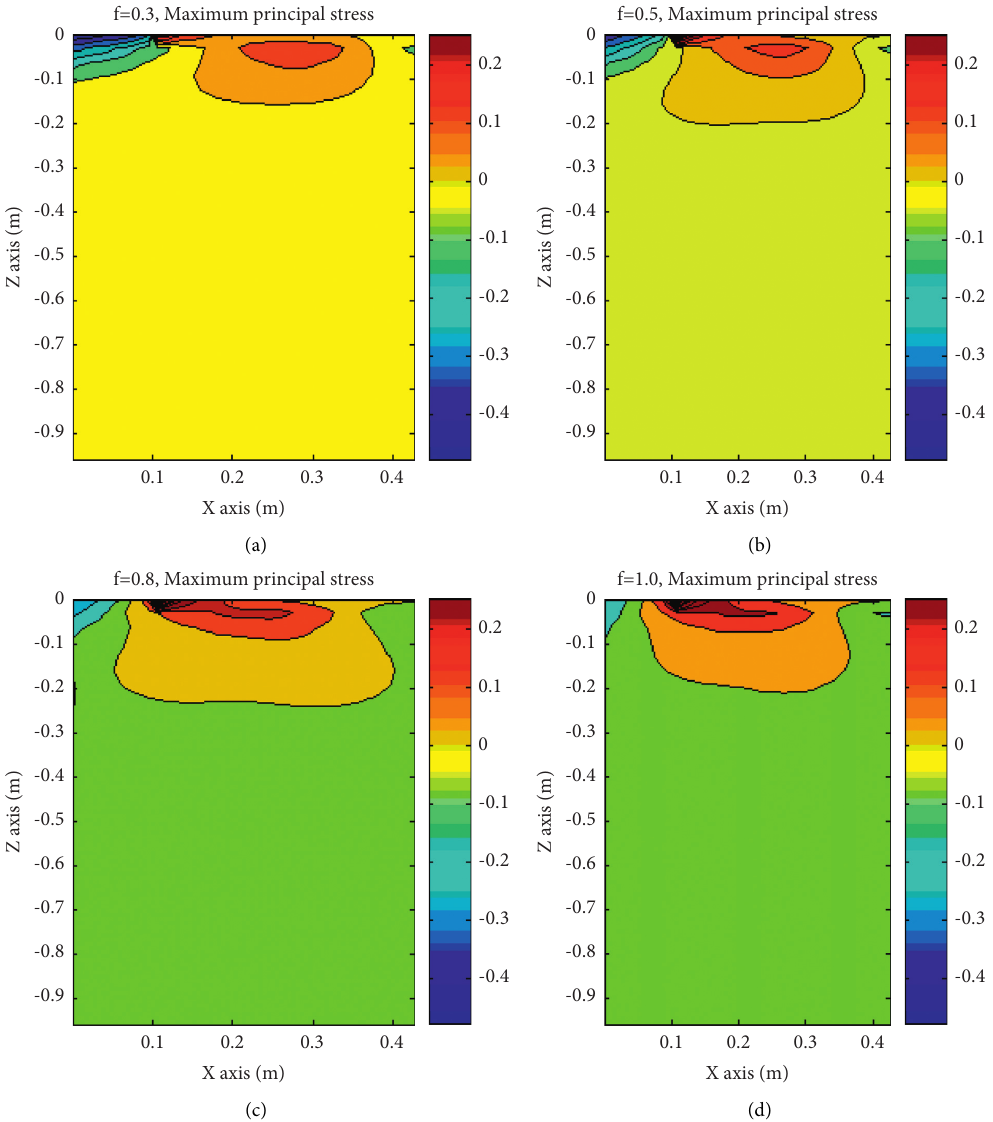
Figure 5: Maximum principal stress nephogram under different friction coefficients. (a) f � 0.3. (b) f � 0.5. (c) f � 0.8. (d) f �